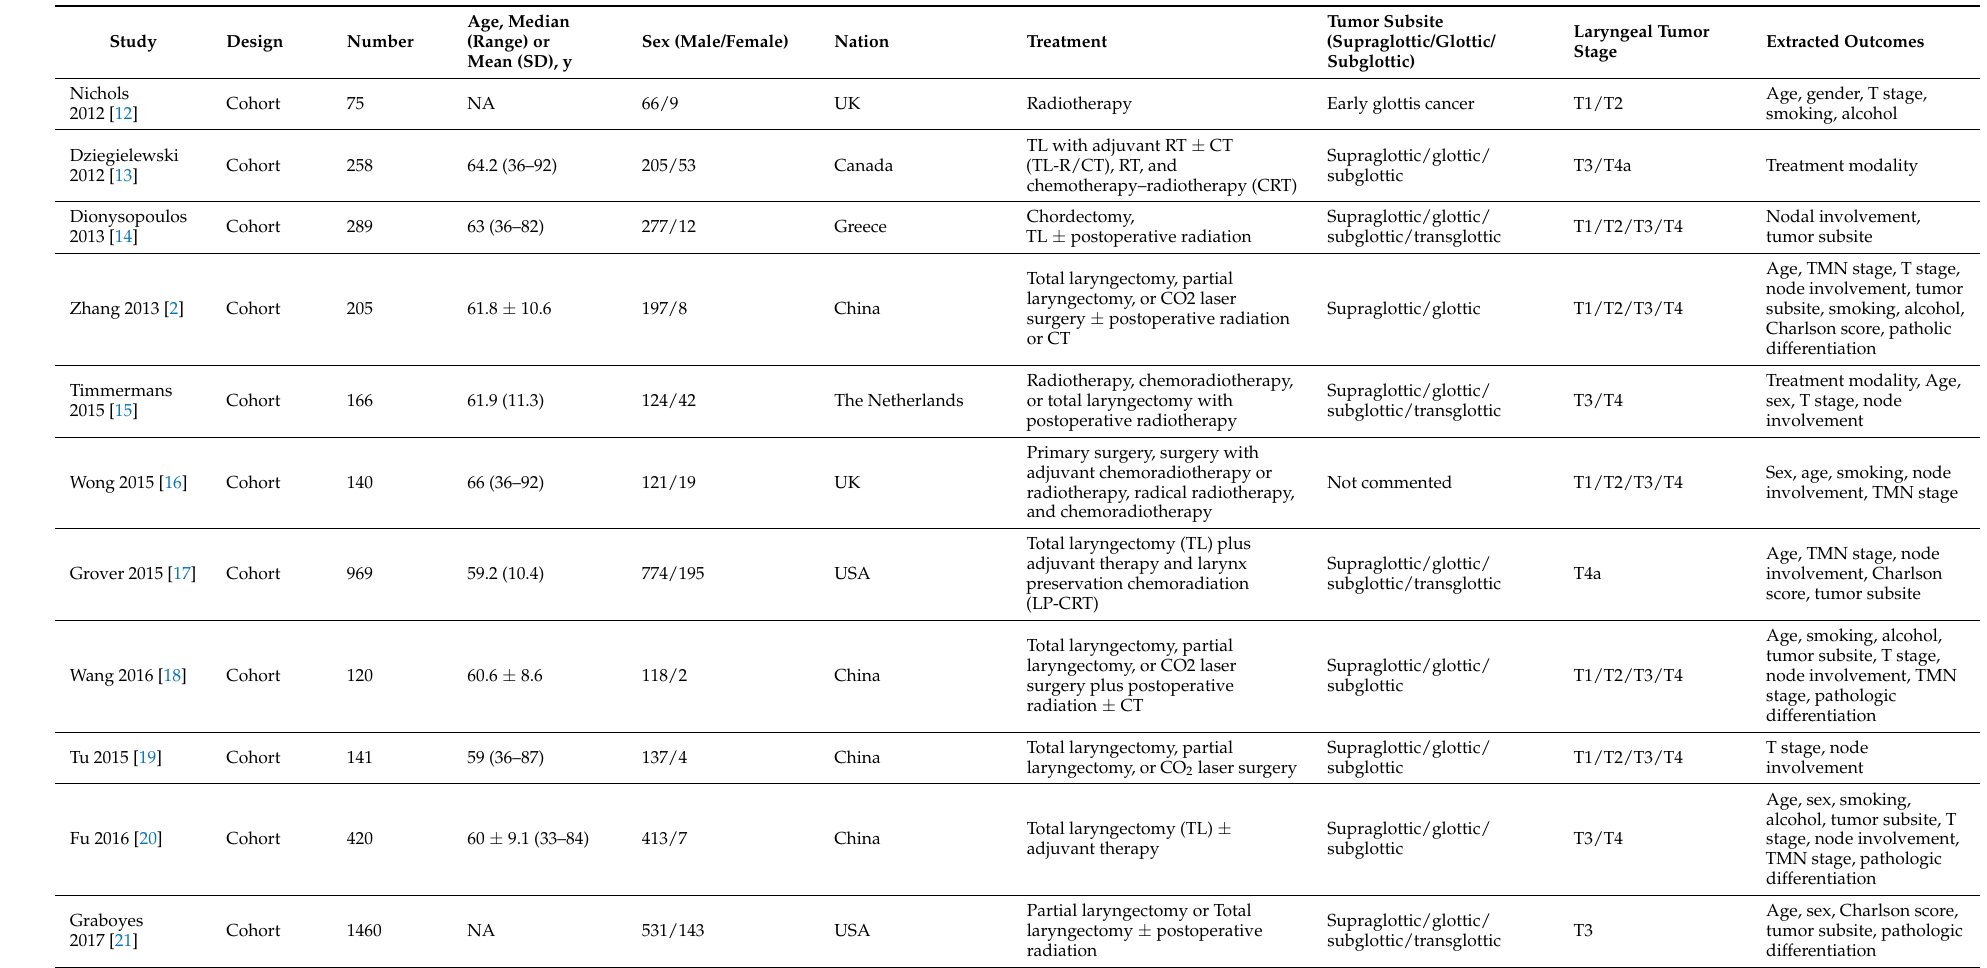
Table 1. The characteristics of the included